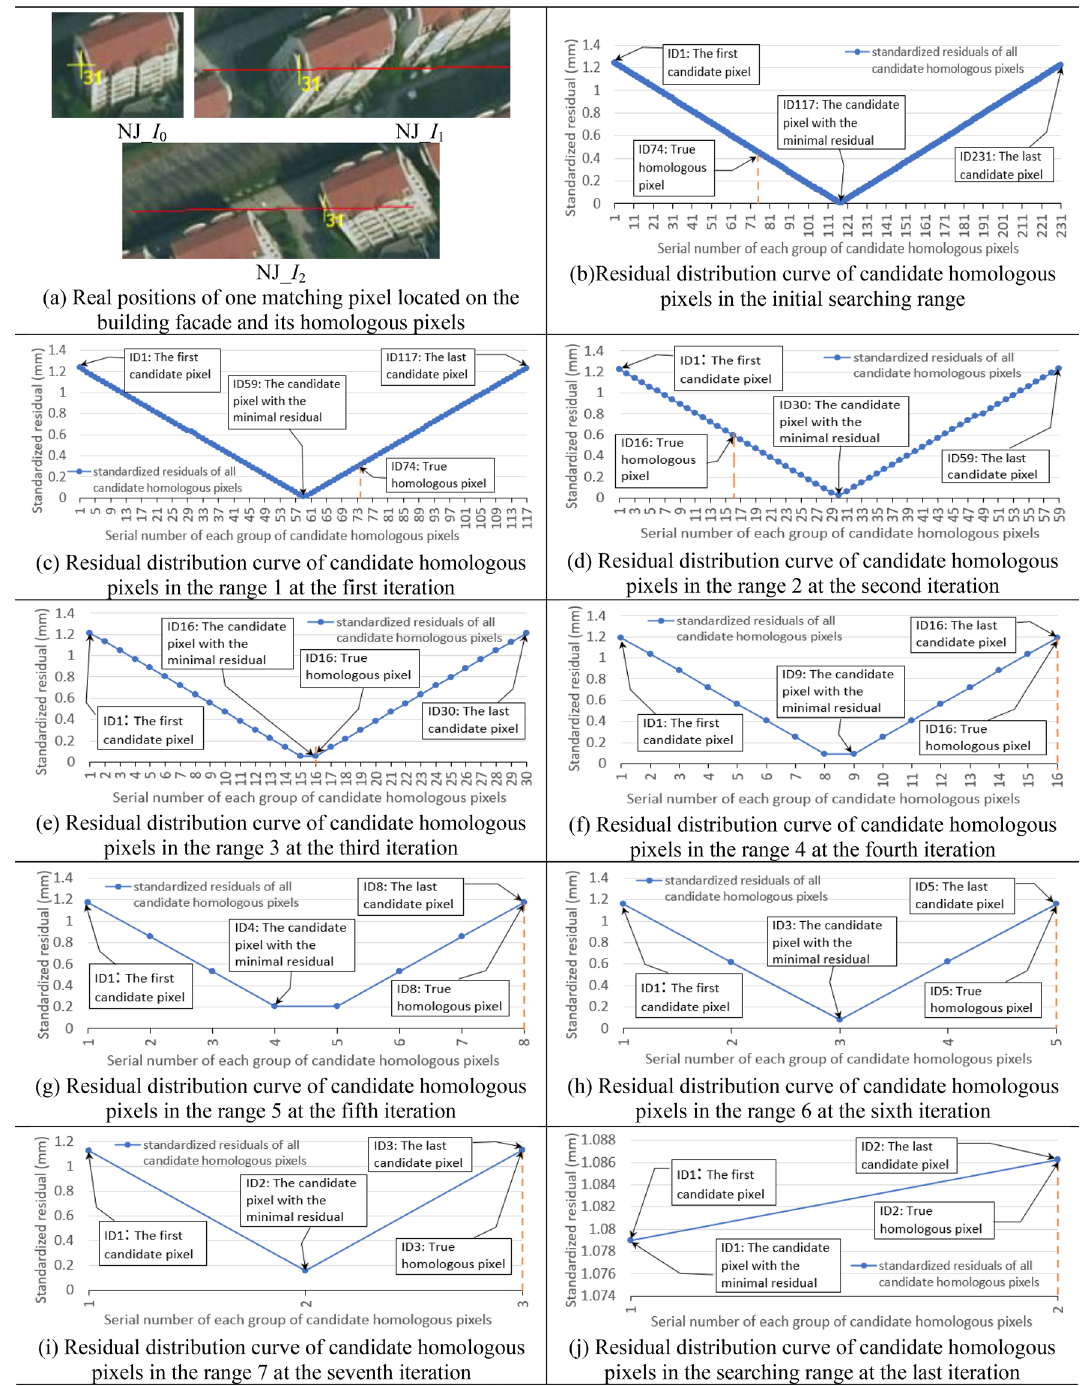
Figure 8. The experimental results of positional distribution form among candidate homologous pixels for one matching pixel located on the building facade in Nanjing experimental images NJ_ I 0 -NJ_ I 1 -NJ_ I 2 (Graphs in (b) to (j) were created by Microsoft Excel middle of all candidate pixels, and the real homologous pixel lies on either the left or right of the valley point (including this valley point). Utilizing the V-shaped distribution pattern among candidate homologous pixels, the iterative refinement of searching range in the searching image can be realized. After refinement, the total number of candidate homolo- gous pixels in each searching image will be reduced from initial hundreds (depending on the size of the initial searching range) to final two adjacent pixels containing the real homologous pixel. However, for different images